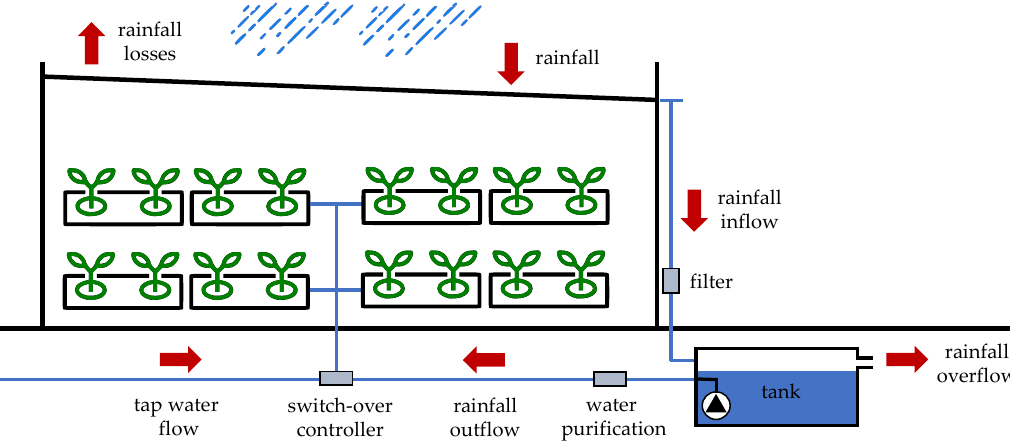
Figure 2. The diagram of the water flow in the rainwater harvesting system.